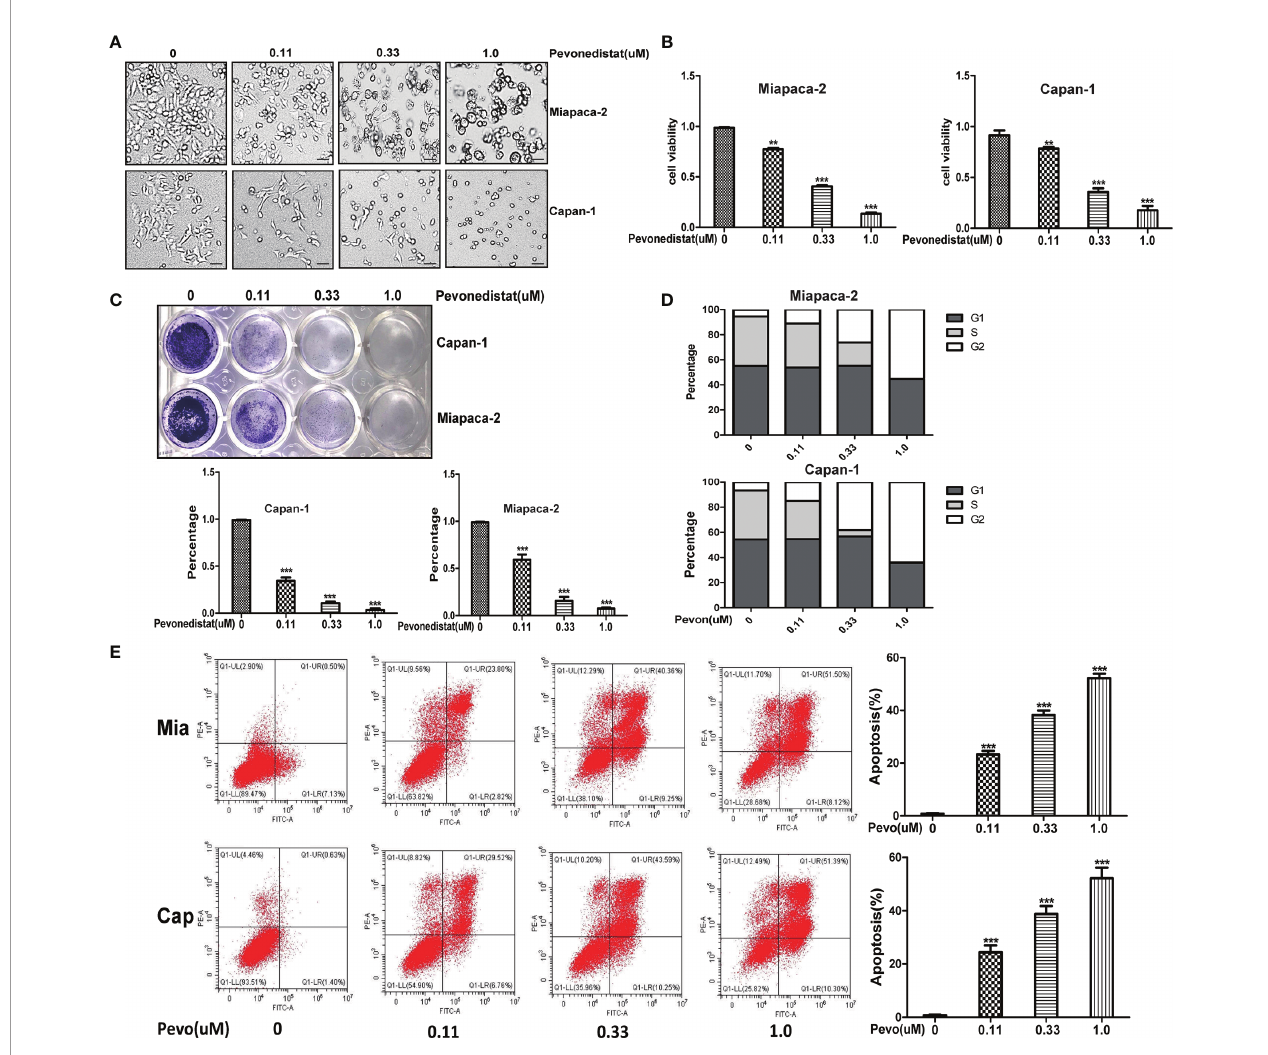
FIGURE 2 | Pevonedistat impeded the malignant phenotypes of pancreatic cancer cells in vitro . (A) Growth suppression of pancreatic cancer cells by pevonedistat. Miapaca-2 and Capan-1 cells were treated with different doses of pevonedistat for 72 h and subjected to the micrograph. Scale bar = 200 m m. (B) Pevonedistat inhibited pancreatic cancer cell proliferation. A total of 2,500 Miapaca-2 and Capan-1 cells were seeded in 96-well plates in triplicates, treated with different doses of pevonedistat for 72 h, and then subjected for Cell Counting Kit-8 (CCK8) assay (mean ± SD, **p < 0.01, ***p < 0.001, n = 3). (C) Pevonedistat suppressed colony formation in pancreatic cancer cells. Miapaca-2 and Capan-1 cells were seeded into 12-well plates with 100 cells per well, cultured overnight, and then treated with indicated concentrations of pevonedistat for 10 days, followed by crystal violet staining and colony counting (mean ± SD, ***p < 0.001, n = 3). (D) Pevonedistat induced G2-M cell cycle defects. Miapaca-2 and Capan-1 cells seeded into 60-mm dishes were treated with pevonedistat at 0.11, 0.33, and 1.0 m M vs. dimethyl sulfoxide (DMSO) for 48 h, followed by propidium iodide (PI) staining and fl uorescence-activated cell sorting (FACS) analysis for cell cycle pro fi le. (E) Pevonedistat induced apoptosis in a dose-dependent manner. Miapaca-2 and Capan-1 cells, treated with pevonedistat at 0.11, 0.33, and 1.0 m M vs. DMSO for 72 h, were subjected to Annexin V-FITC/PI double-staining analysis. (mean ± SD, ***p < 0.001, n = 3). These data were representative results of three independent experiments with similar trends. Data represent means, and error bars are SD. Two-sided